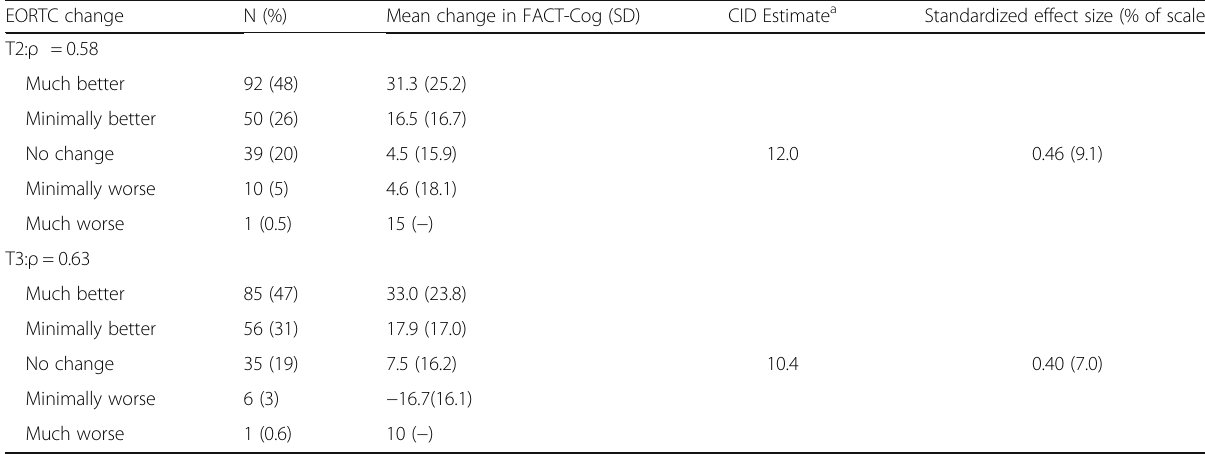
Table 6 Anchor-based CID estimates based on changes from post-intervention and six month follow-up for the 37-item FACT-Cog total score EORTC change N (%) Mean change in FACT-Cog (SD) CID Estimate a Standardized effect size (% of